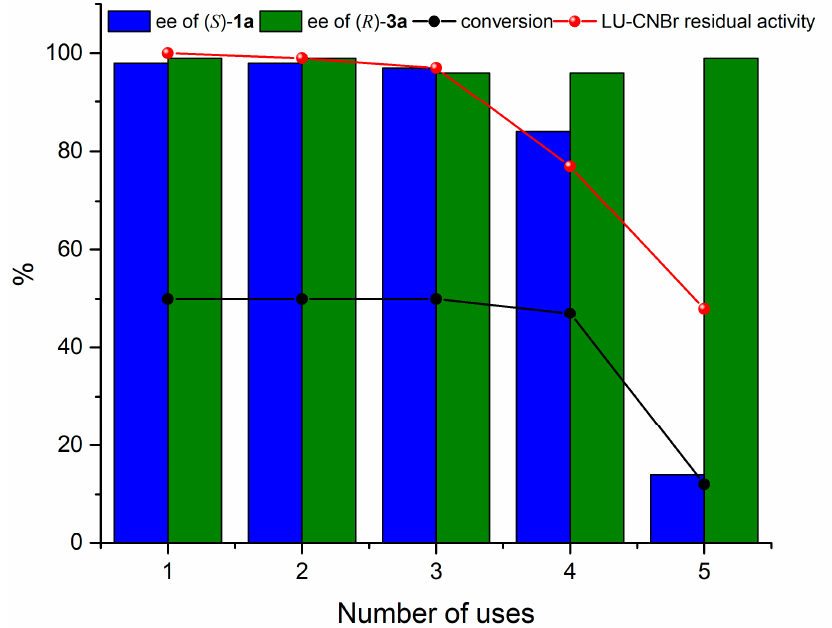
Figure 4. Operational stability of LU-CNBr and the parameters of the kinetic resolution of racemic ( E )-4-phenylbut-2-en-3-ol ( 1a ) in the process of transesterification in subsequent reaction cycles (24 h reactions with vinyl propionate in DIPE, 0.06 U of enzyme).